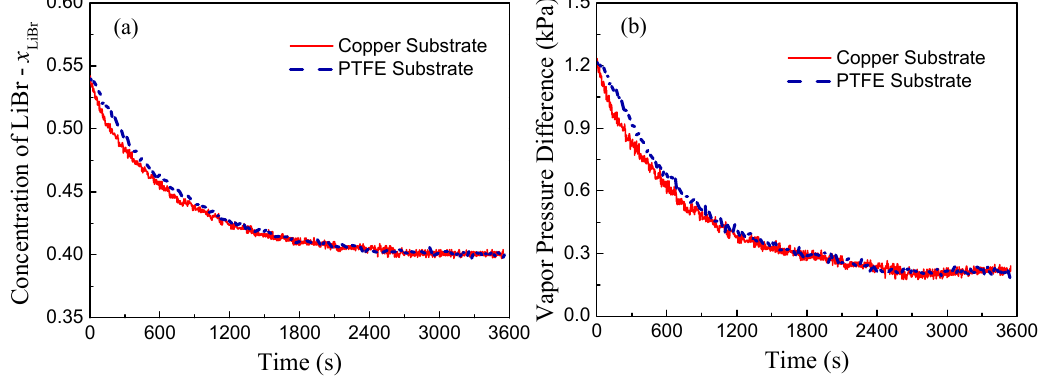
Figure 4. Evolution of ( a ) solute concentration, x LiBr , and ( b ) vapor pressure difference between surrounding air and liquid-air interface of LiBr-H 2 O droplets on copper and PTFE substrates coated with FEP for 25 °C and 60% RH conditions.